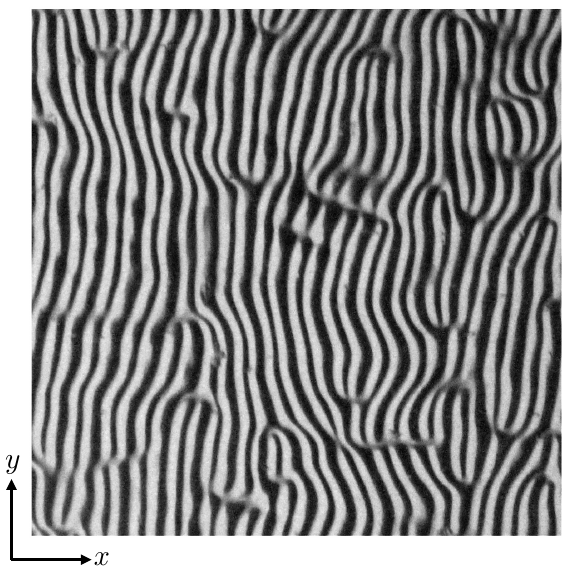
Figure 1. Snapshot of defect turbulence. White lines correspond to convective